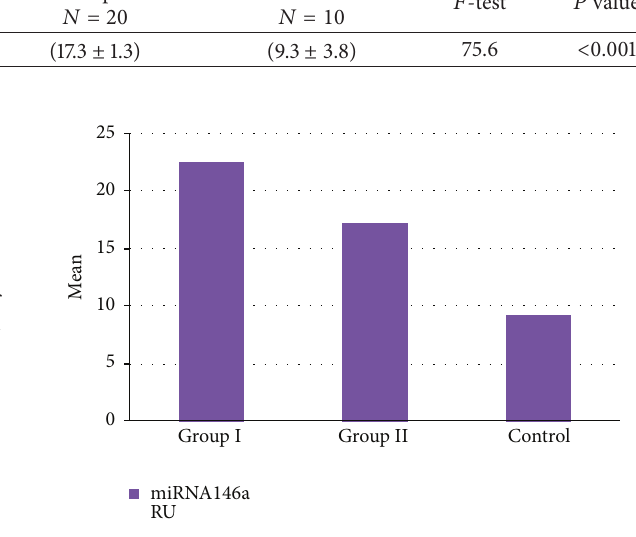
Figure 1: Comparison between group I, group II patients and con- trol group as regards level of miRNA146a. Table 3: Comparison between patient groups as regards level of miR146a before and after